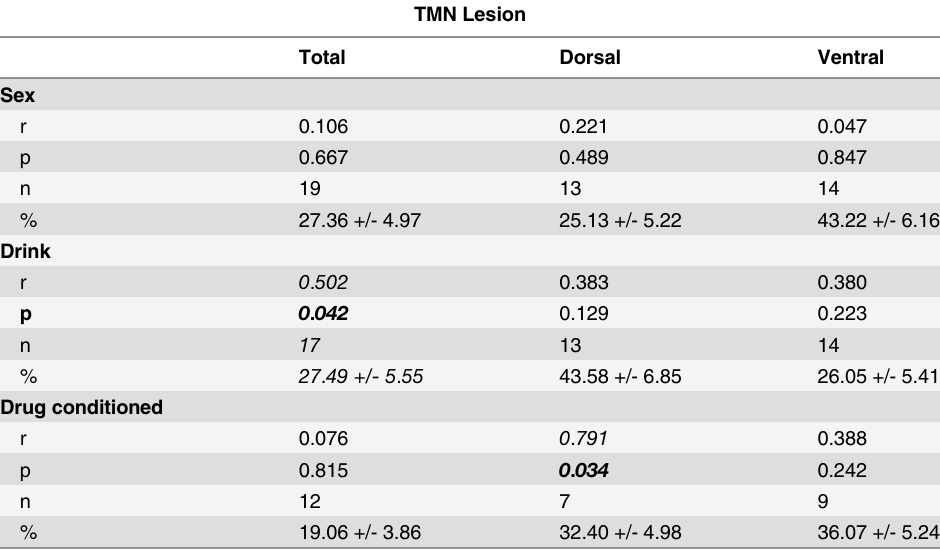
The r and p values of the regression, the number of animals (n) and the % of the lesion, are indicated. Signi fi cant regressions are in